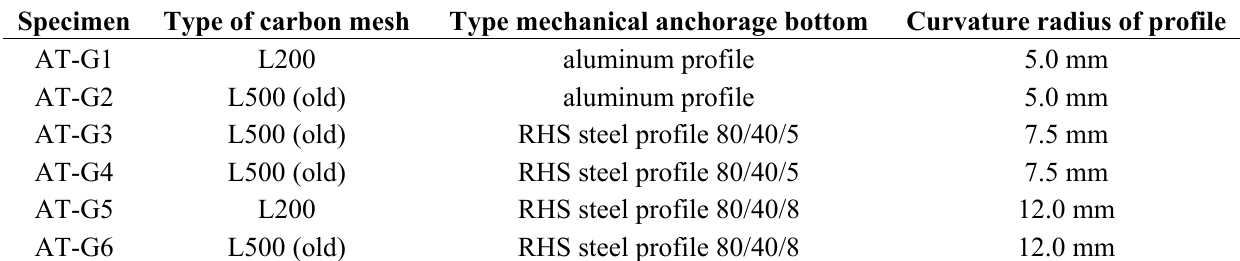
Table 7. Tested configurations of retrofitted masonry elements in Series AT-G.